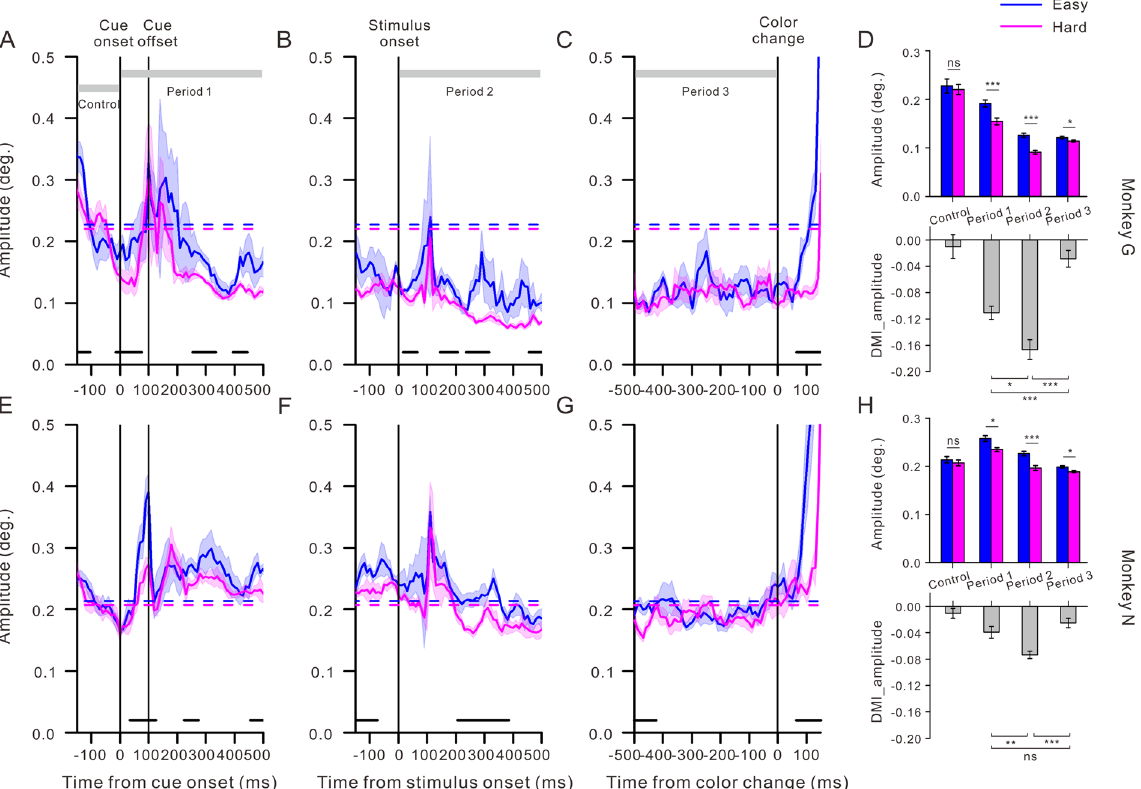
Figure 3. The temporal dynamics of the microsaccade amplitude and the modulations of perceptual load on the microsaccade amplitude during different time periods. ( A – C , E – G ) Temporal comparison of the microsaccade amplitude between the easy (blue) and hard (pink) conditions for monkeys G and N. For each monkey, the microsaccade amplitude demonstrated a transient increase around the time of the minimum rate seen in the earlier figure after the cue or stimulus appearance and the target color change onset. The horizontal dashed lines represent the average amplitude during the period of Control. The black lines at the bottom of each plot demonstrate the periods in which the microsaccade amplitude under the two conditions differed significantly ( p < 0.05, Student t test). The gray rectangles are defined as in Fig. 2. ( D , H ) Measures of the perceptual load modulation on the microsaccade amplitude during different periods. For both monkeys, the top panels show the average microsaccade amplitude during the easy (blue) and hard (pink) tasks in the four periods. The bottom panels show the DMI ratios of the microsaccade amplitude within the four time periods. Error bars indicate SEMs, which are defined in Fig.